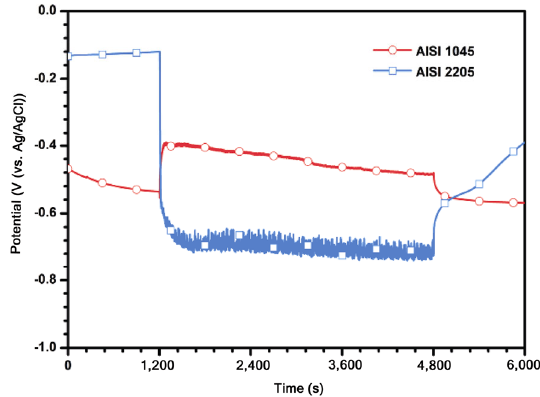
Fig. 2 Evolution of the OCP of tested samples immersed in seawater before, during, and after sliding.